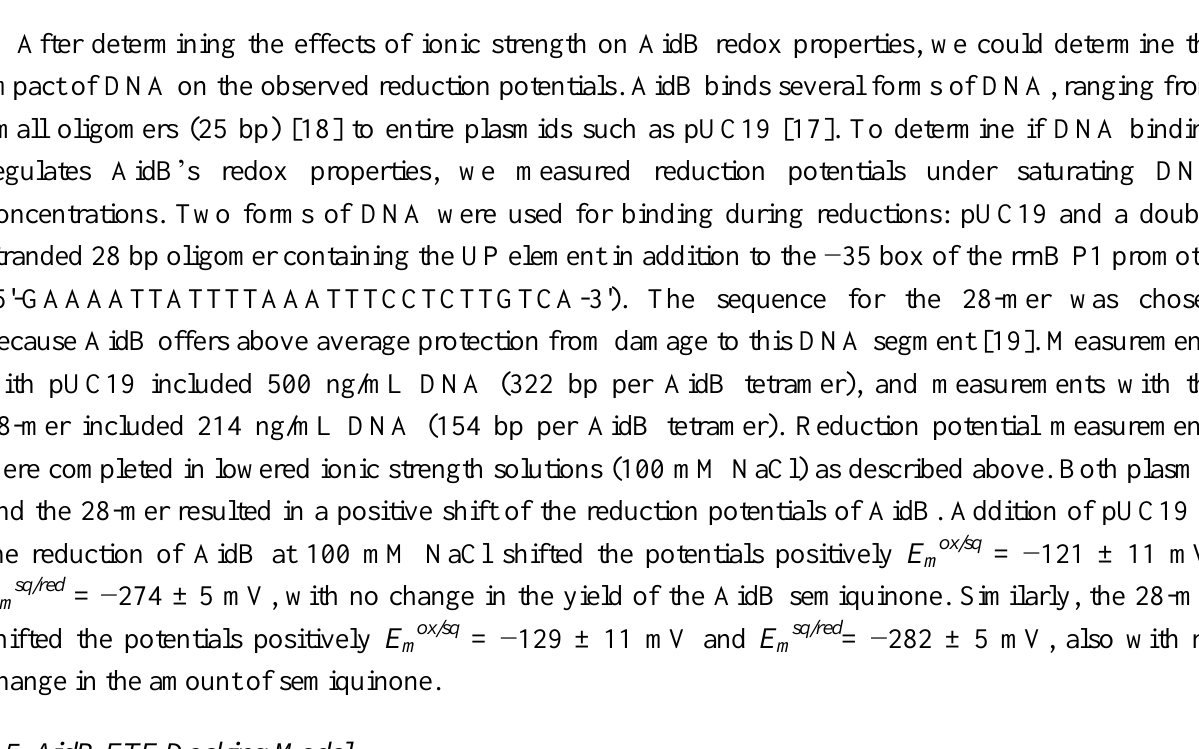
Figure 5. Midpoint reduction potential ( E